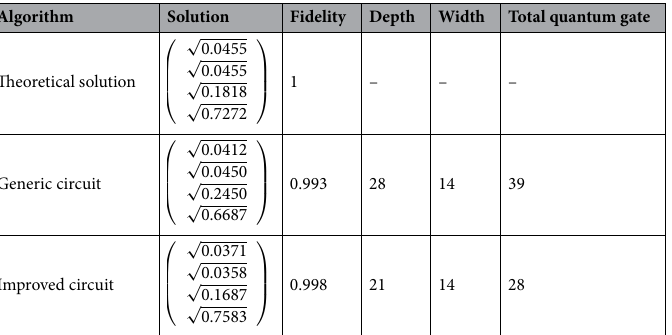
4 linear system. When using quantum ×